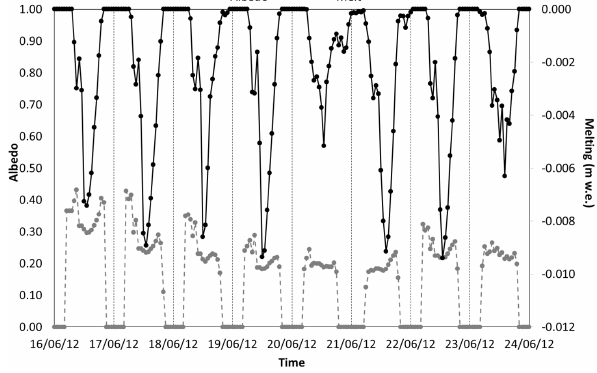
Figure 6. Comparison between albedo measured by the AWS1 Forni (grey line) and melting amount estimated by the energy bal- ance model (black